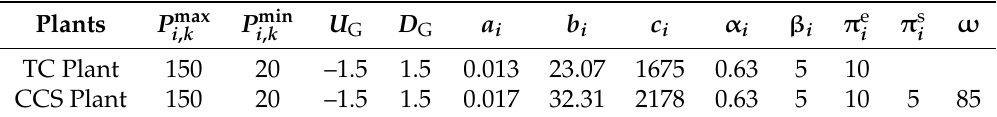
Figure 3. 30 node drid system. CCS: carbon capture and storage. TC: traditional coal-fired power generating unit. Table 1. Simulation parameters of the used thermal